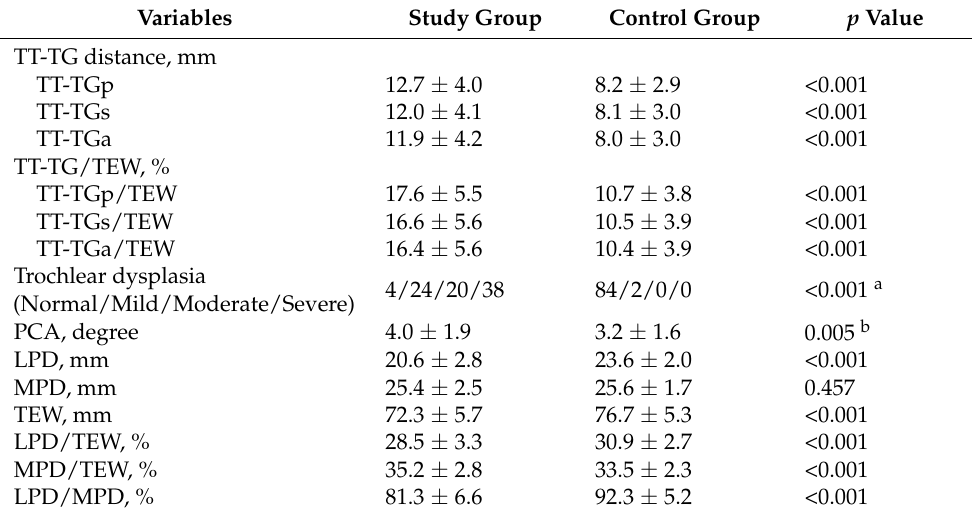
Table 2. Differences in the measurements between the study group and the control